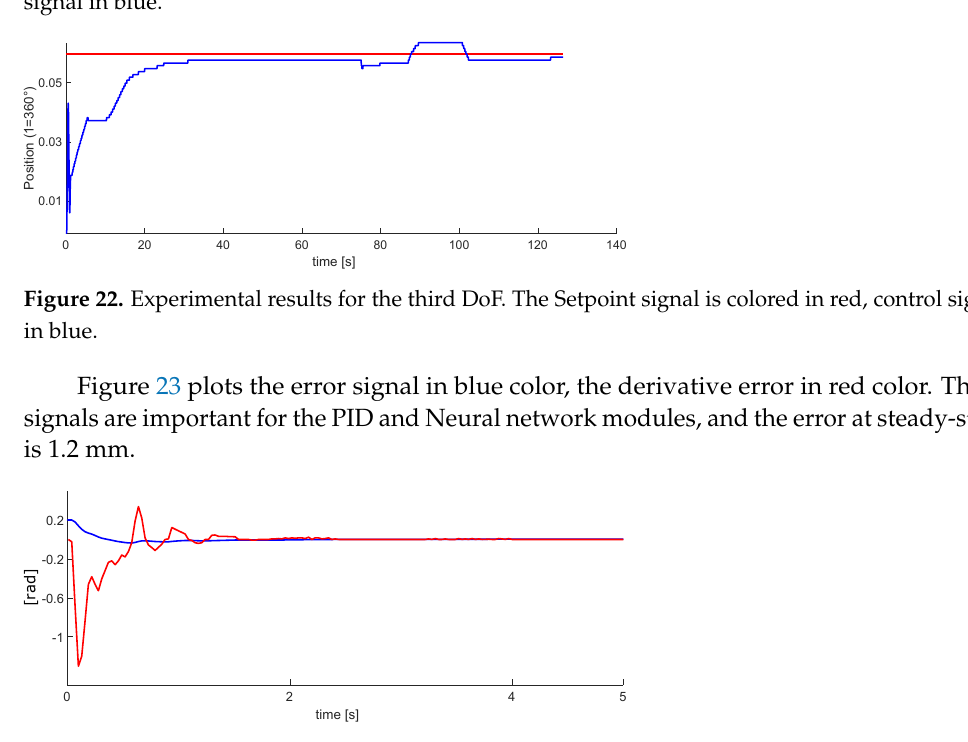
Figure 23. Experimental results for the error signal (blue) and derivative error (red) of a